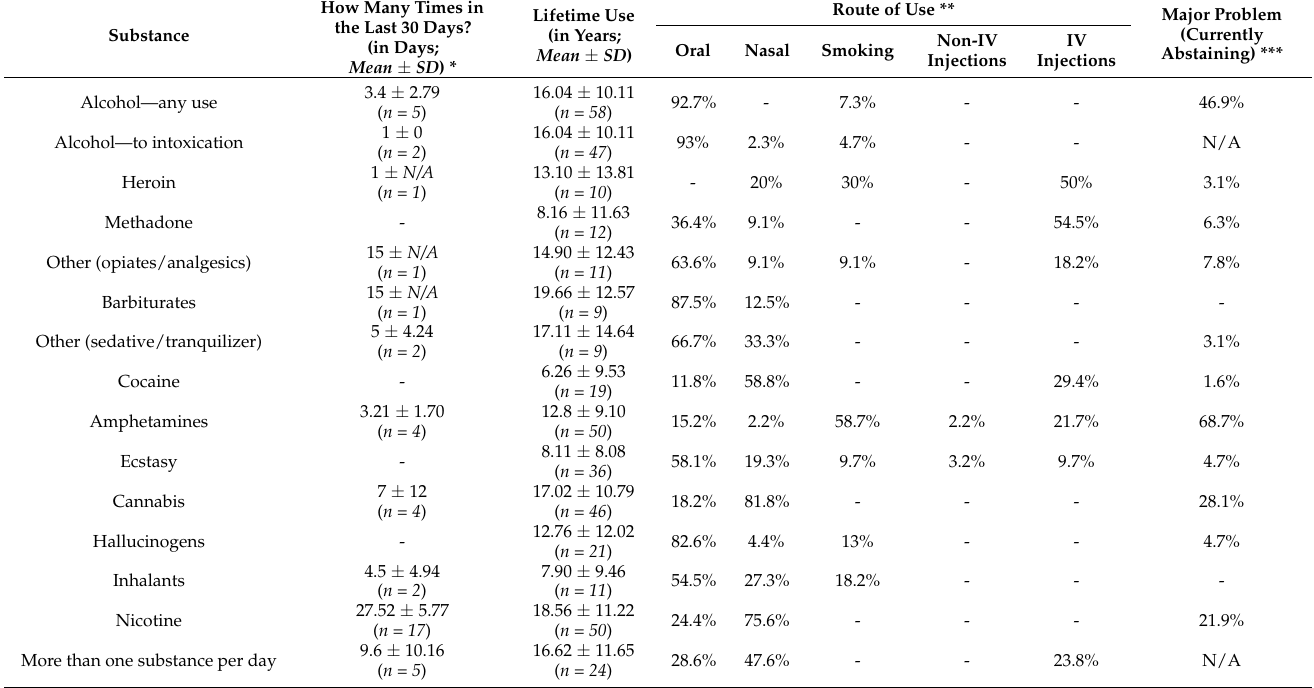
Table 2. Additional substance use information (clinical group).